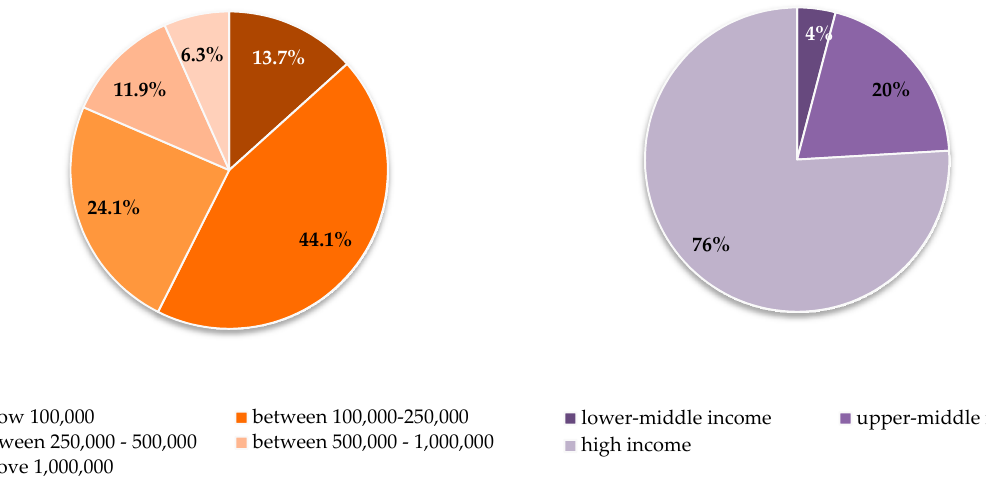
Figure 1. Structure of the analyzed selected European cities.